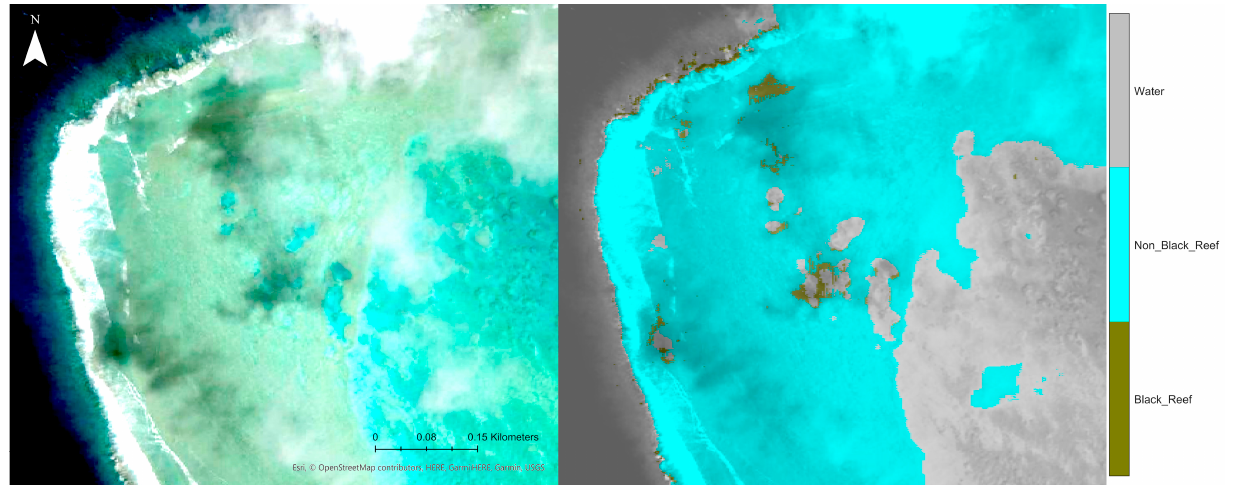
Figure 9. ( Left ) a zoomed part of the Google Earth image (Google Earth Pro, 2011) of Rose reef (northwest corner) that shows the presence of clouds. ( Right ) the resulting segmented image where the shadows of the clouds have been falsely identi fi ed as black reefs.